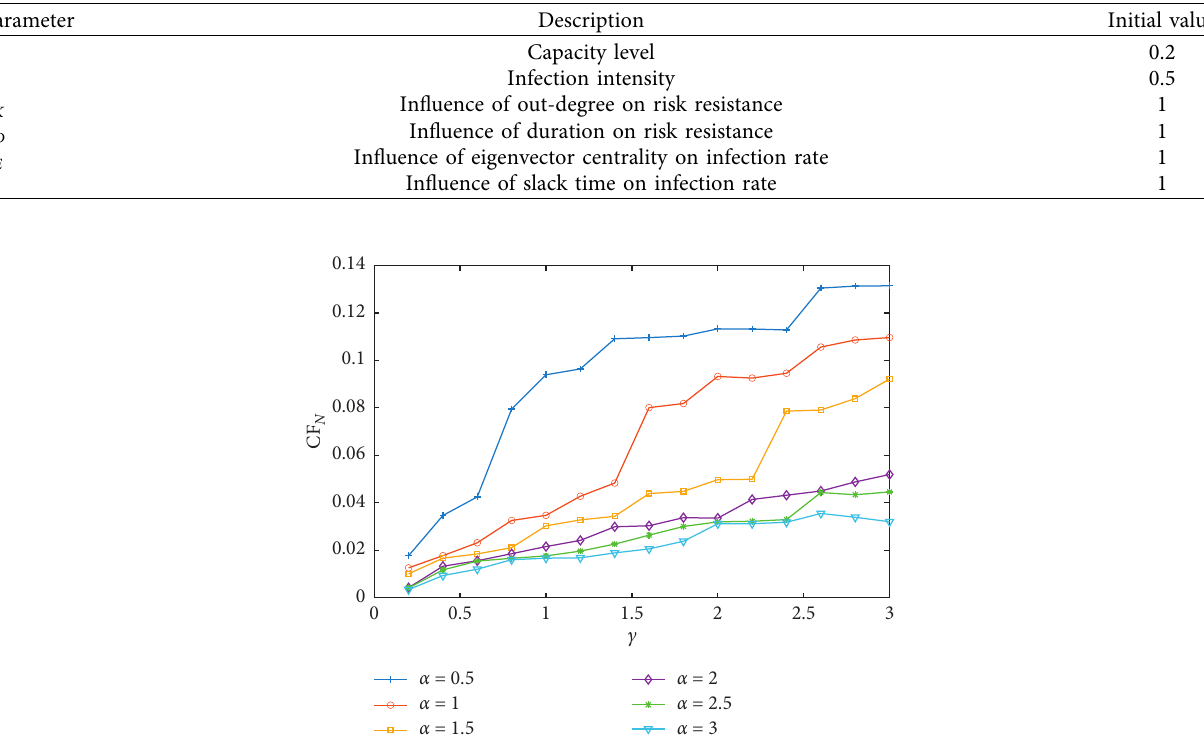
c for different α . N and